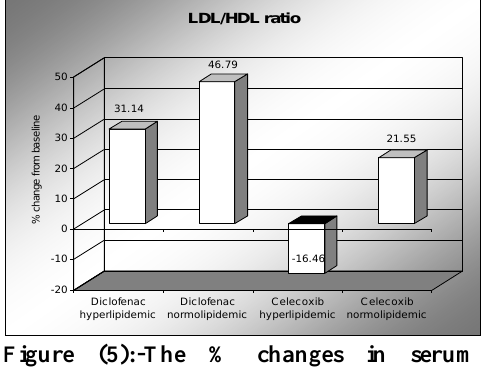
Figure (5):-The % changes in serum LDL/HDL ratio concentration from baseline value after 8weeks treatment with diclofenac or celecoxib in hyperlipidemic and normolipidemic type 2 diabetic patients